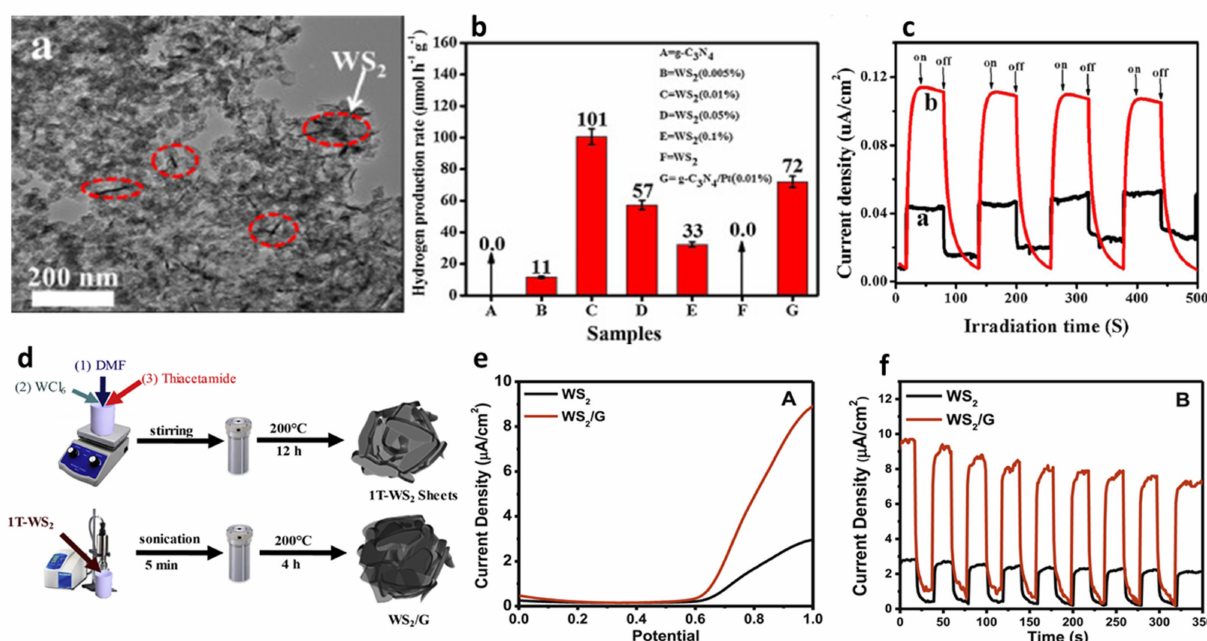
Figure 20. ( a ) TEM image of the of g–C 3 N 4 /WS 2 (0.01%) sample. ( b ) The rate of hydrogen production by WS 2 , g-C 3 N 4 , and their heterostructures with different amount of WS 2 . ( c ) Photocurrent response of a: pure WS 2 and b: WS 2 @ g-C 3 N 4 (0.01%). Reproduced with permission [155]. Copyright 2015, Elsevier. ( d ) Schematic diagram for the synthesis route of WS 2 /G heterostructure. ( e ) LSV and ( f ) chopped voltammetry at 1 V vs. SCE of pure WS 2 and WS 2 /G heterostructure. Reproduced with permission [156]. Copyright 2020,